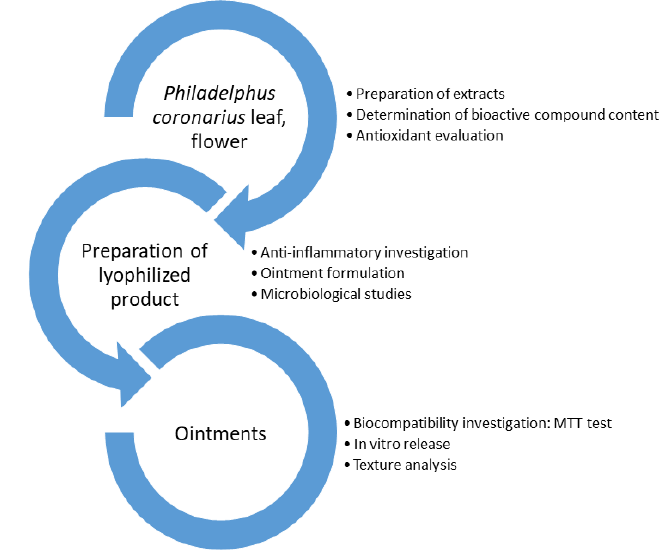
Figure 1. Experimental design.